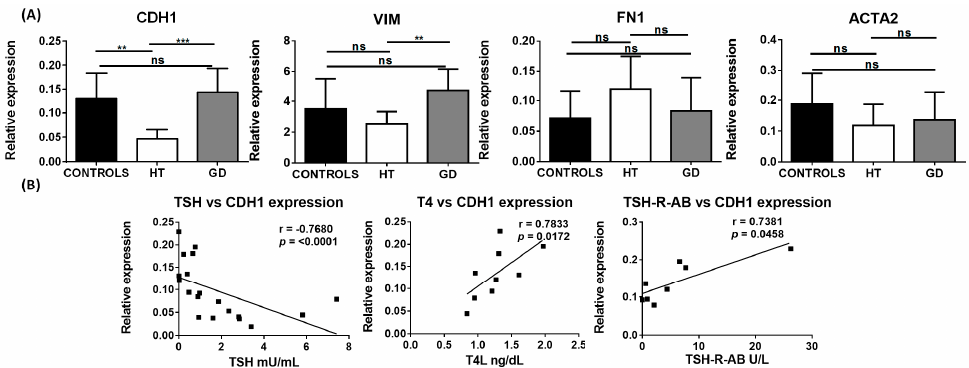
Figure 1. RNA expression of EMT-associated markers in thyroid tissue from controls, HT, and GD patients. ( A ) RT-qPCR expression of E-cadherin ( CDH1 ), vimentin ( VIM ), fibronectin ( FN1 ), and α -SMA ( ACTA2 ) in bulk thyroid tissue samples. Data correspond to the arithmetic mean ± SD. ( B ) Significant correlation analysis of the genes analyzed by RT-qPCR with different clinical laboratory parameters. Abbreviations—ns: not significant, TSH: thyroid-stimulating hormone; FT4: free-T4 hormone; TSH-R-Ab: TSH receptor antibody. ** p < 0.01; *** p < 0.005.